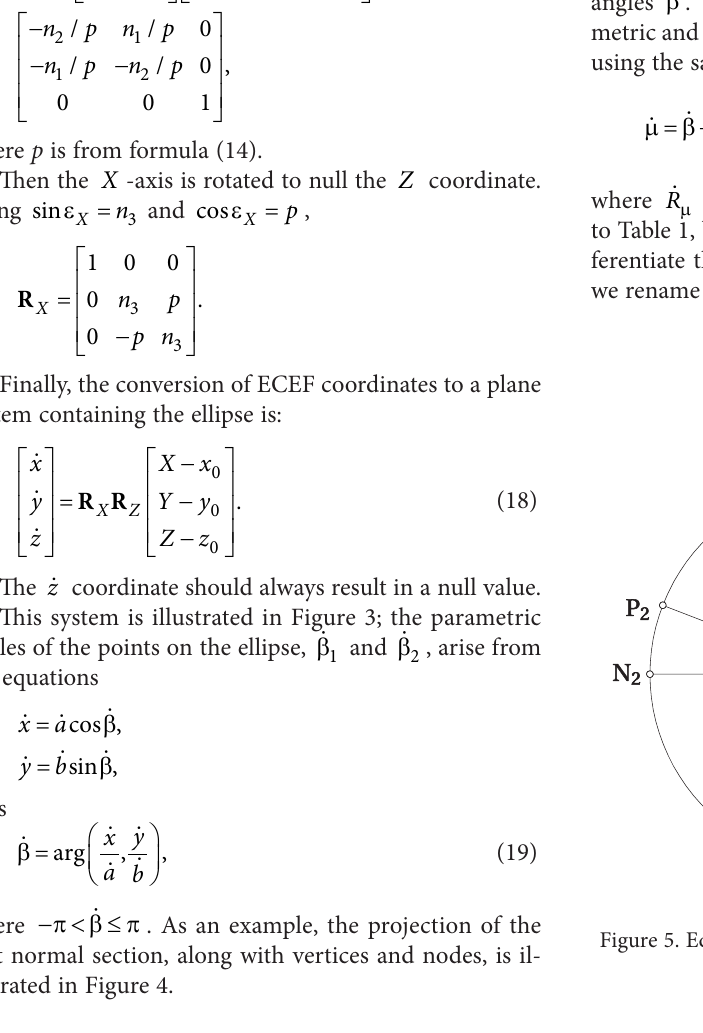
Table 1. Formulas to calculate R µ and µ based on the third flattening n and the parametric latitude β (Orihuela,